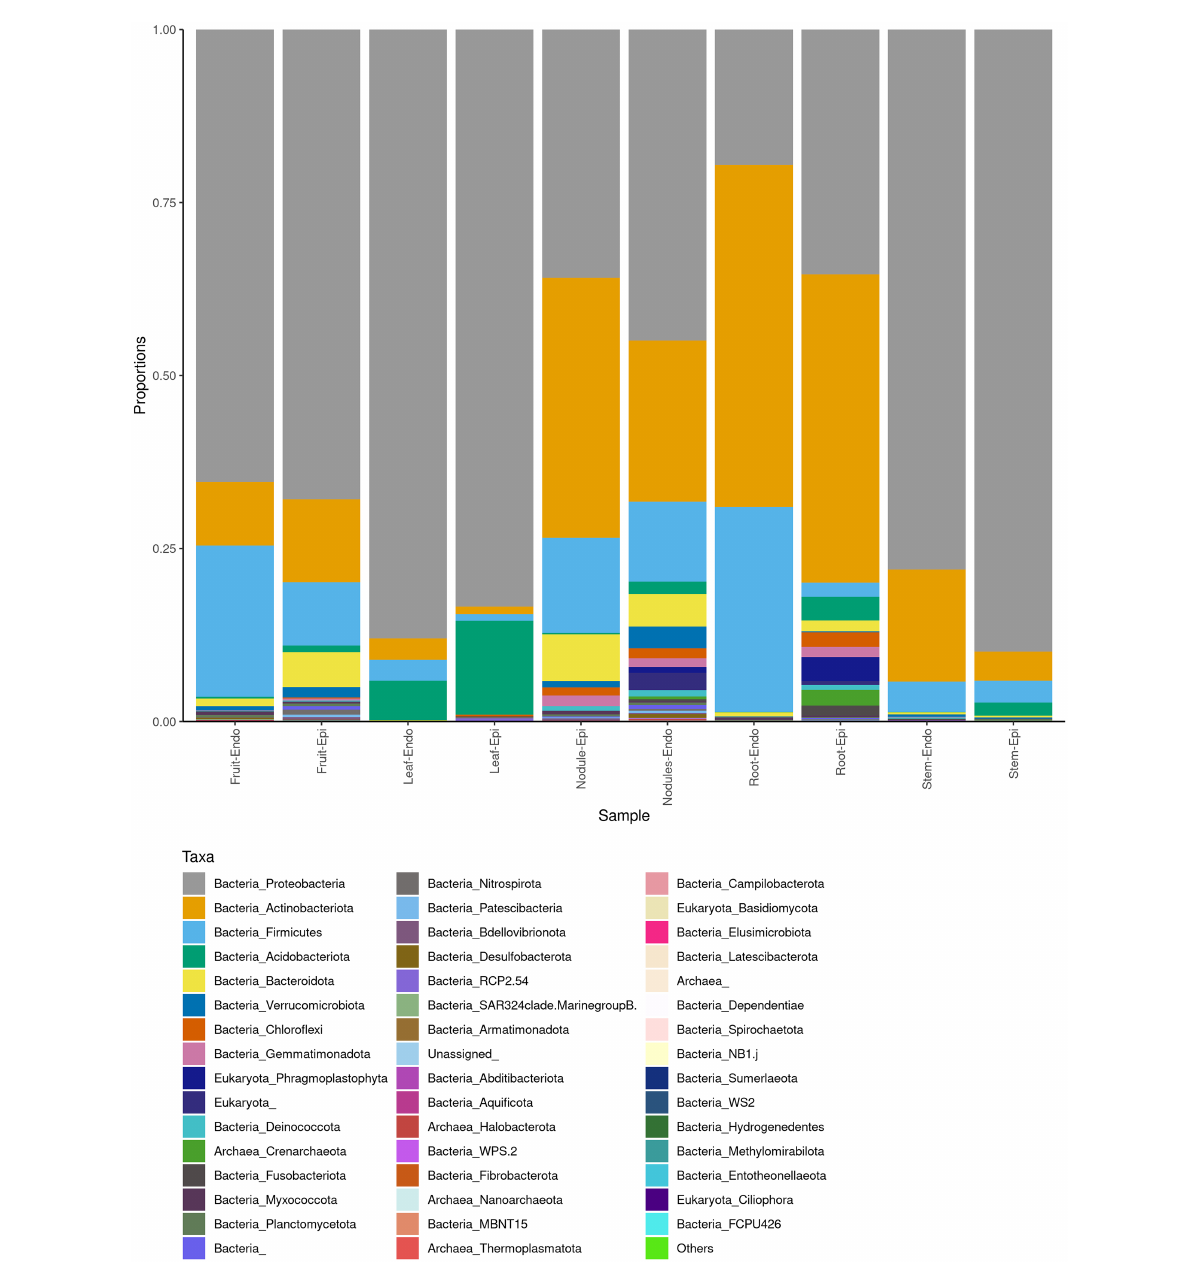
FIGURE 3 Phylum level taxonomy of Coriaria myrtifolia phytomicrobiome. Average 16S amplicon data show the relative abundance of each phylum after rarefying. Bars represent the average relative abundance of a given taxa across three replicate samples. Both epiphytic (Epi) and endophytic (Endo) communities are